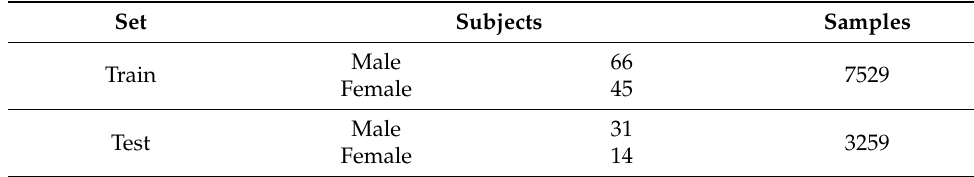
Table 2. Data-set